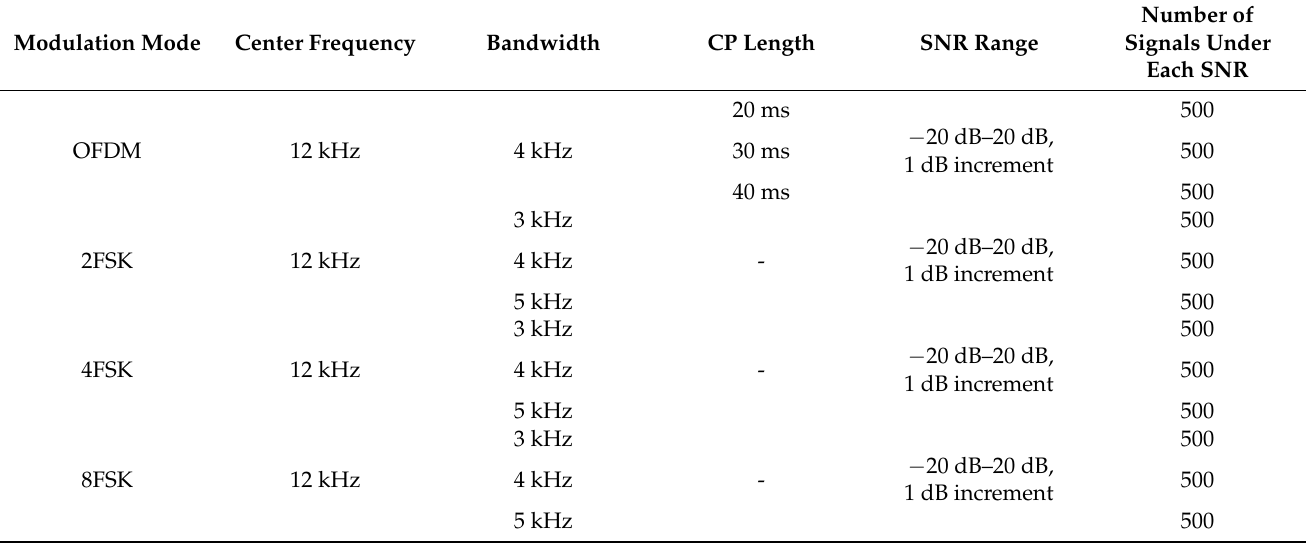
Table 2. Parameter setting of the validation